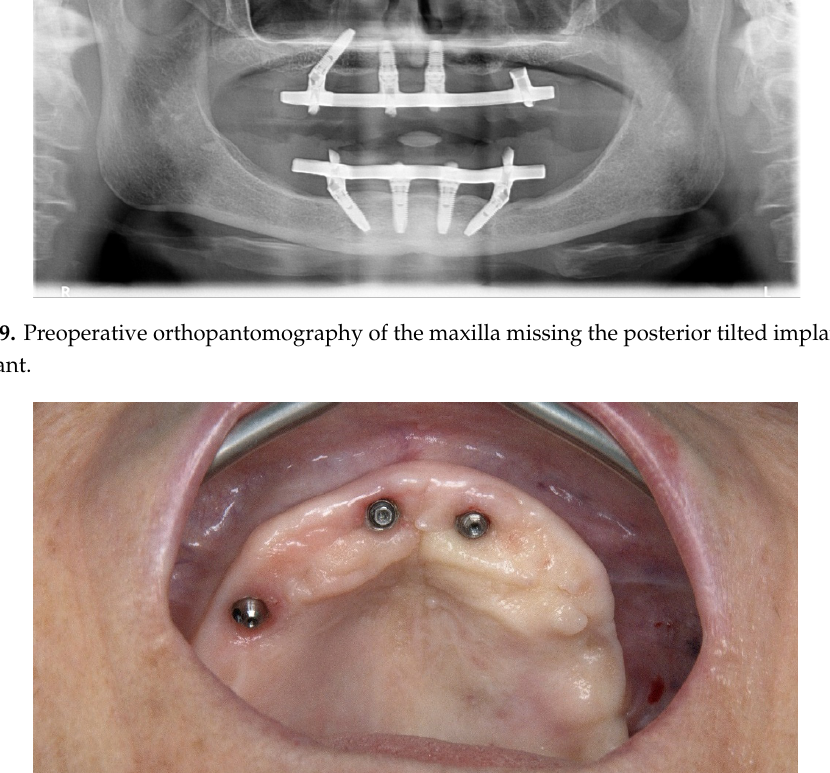
Figure 20. Pre-operative intraoral photograph exhibiting the occlusal aspect of the maxilla missing the posterior tilted implant on the 3rd sextant.